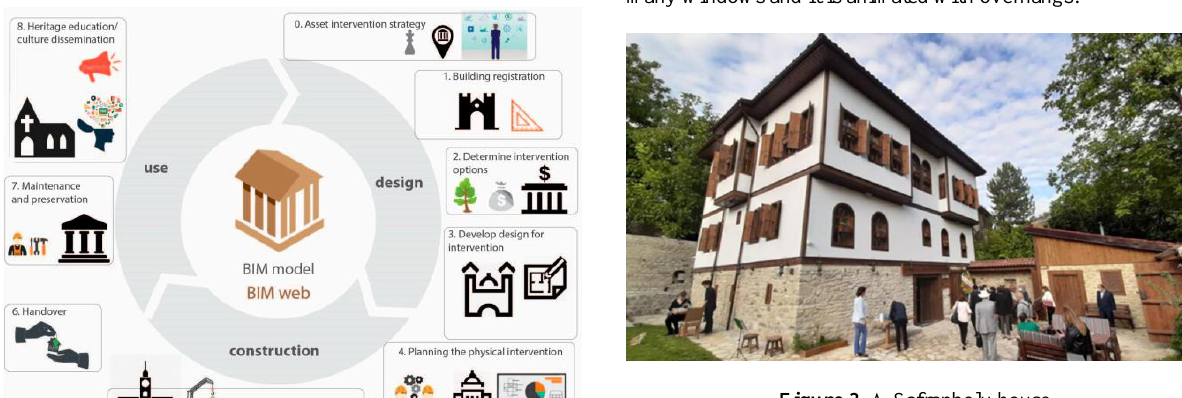
Figure 3 . A Safranbolu